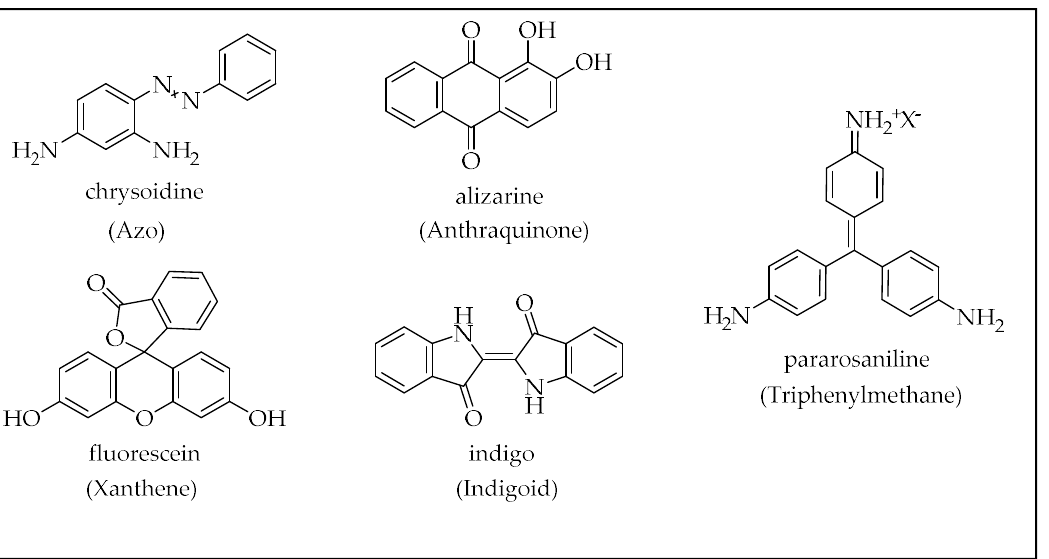
Chart 2: The chemical structures of some common synthetic dyes. Chart 2. The chemical structures of some common synthetic